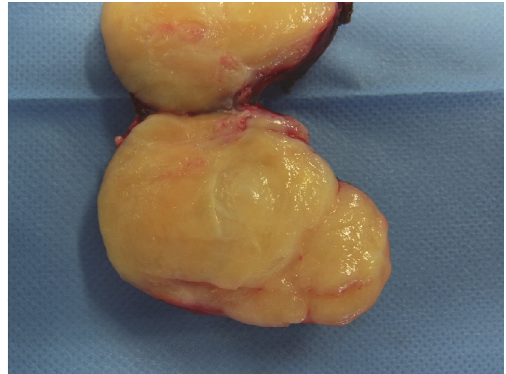
Figure 4: Cut section of the retroperitoneal mass after surgical excision: firm white-greyish mass and a clearly demarcated